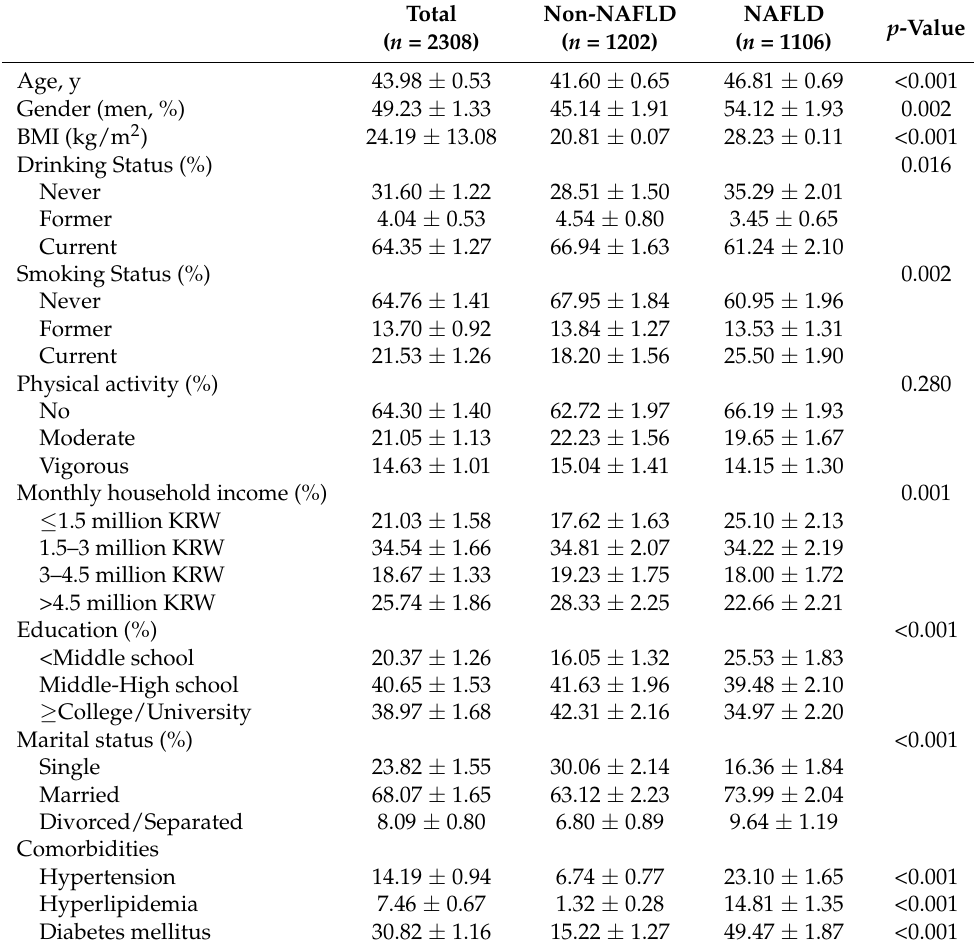
Table 1. General characteristics of the study participants based on the hepatic steatosis